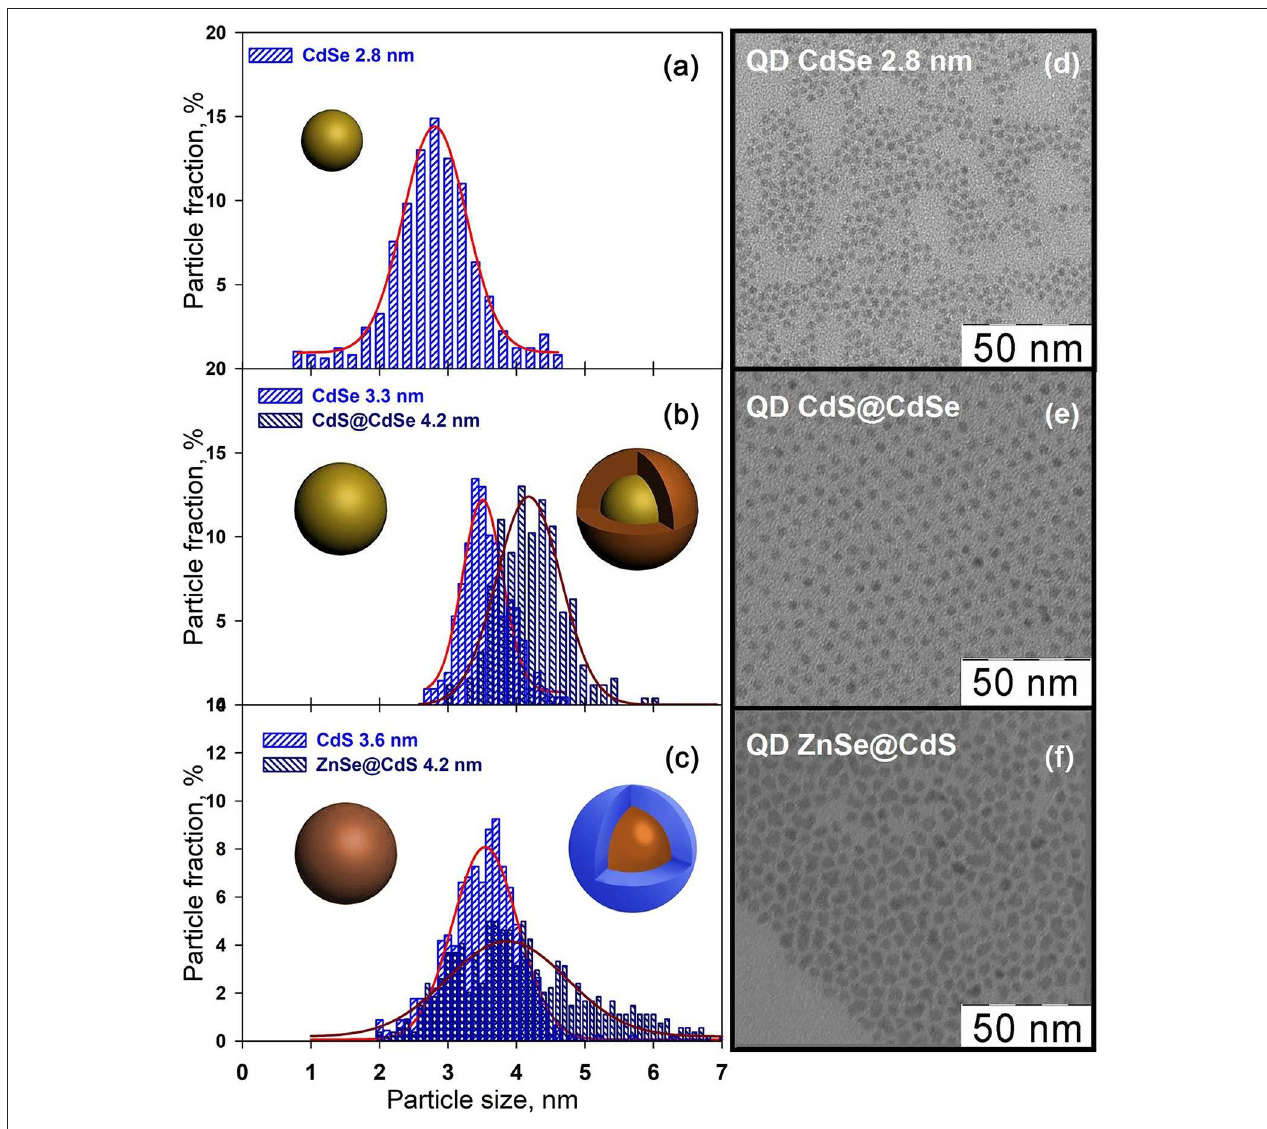
FIGURE 2 | Left panels: Particle size distribution of CdSe (a) , CdS@CdSe (b) , and ZnSe@CdS (c) nanocrystals. For CdS@CdSe and ZnSe@CdS heterostructures, the size distribution for the CdSe and CdS core is also presented. Right panels: Low magnification TEM images of CdSe (d) , CdS@CdSe (e) , and ZnSe@CdS (f)